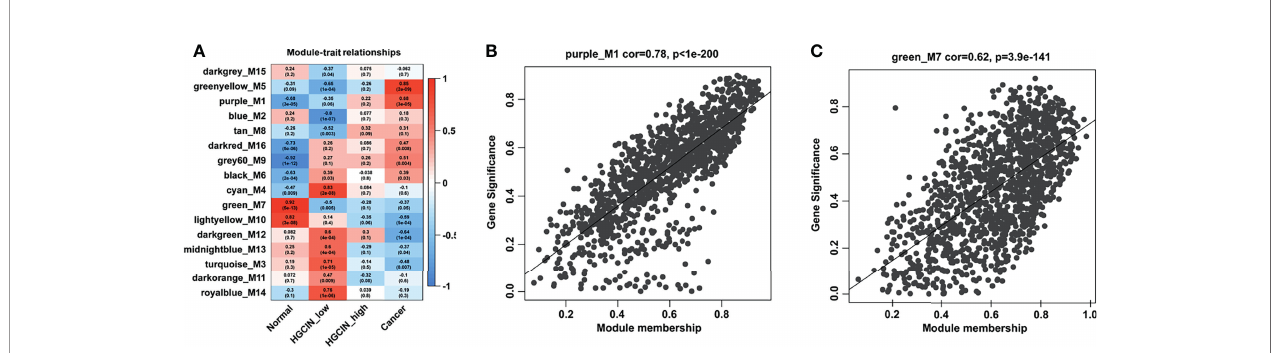
FIGURE 3 | The relationship between modules and clinical traits. (A) Module-trait relationship analysis. Each row indicated a module eigengene, and each column indicated a clinical trait. Each cell included the corresponding correlation and p value. (B) A scatterplot of gene signi fi cance (GS) vs. module membership (MM) in the purple_M1 module (correlation = 0.78, p < 1e-200). (C) A scatterplot of GS vs. MM in the green_M7 module (correlation = 0.62, p < 3.9e-141).